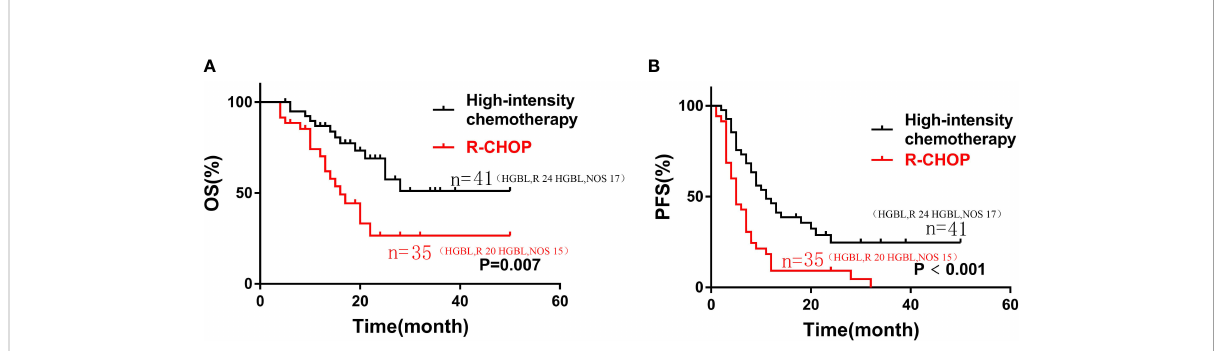
FIGURE 2 Kaplan-Meier curves of OS (A) and PFS (B) according to different induction chemotherapy regimen: high-intensity chemotherapy regimens (n=35) vs. R-CHOP (n=41) in patients with HGBL.